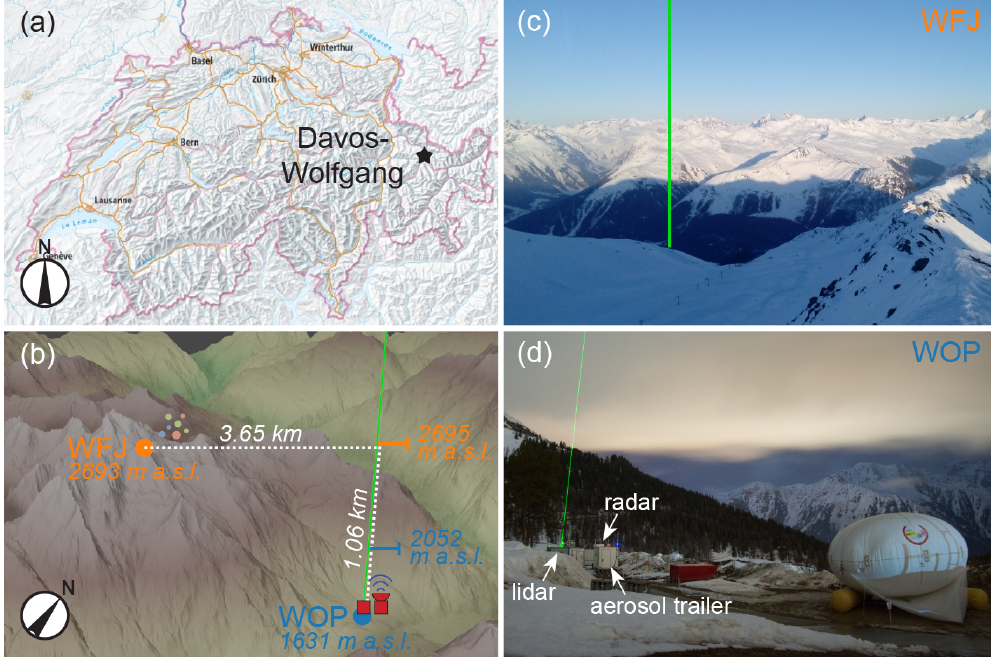
Figure 1. Overview of the measurement locations: (a) Davos-Wolfgang (black star) in the east of Switzerland (map source: Federal Office of Topography). (b) Measurement locations with the local topography around. The OCEANET container and the lower aerosol monitoring site were located in a high valley at Wolfgangpass (blue dot, WOP, 1631ma . s . l . ). A second aerosol measurement site was located on the mountaintop Weissfluhjoch (orange dot, WFJ, 2693ma . s . l . ), which is located approximately 1.1km higher than WOP and horizontally displaced by 3.65km. Lidar product retrieval heights for the comparison with in situ measurements at WFJ and WOP are indicated in orange and blue, respectively, right of the lidar beam (green). The topography was extracted from the digital height model DHM200 from the Federal Office of Topography swisstopo. (c) View from WFJ in direction of WOP. The approximate location of the lidar beam is indicated in green. (d) Placement of the aerosol trailer right of the OCEANET container’s lidar and radar at WOP. The tethered balloon used for in situ cloud observations is seen in the front